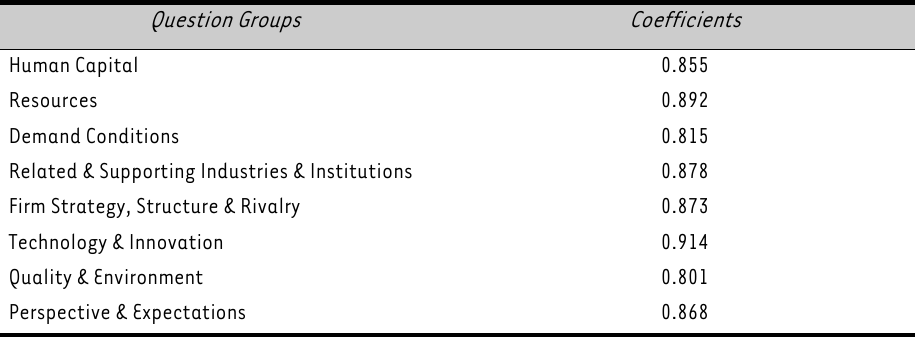
TABLE 1: Cronbach-Alpha